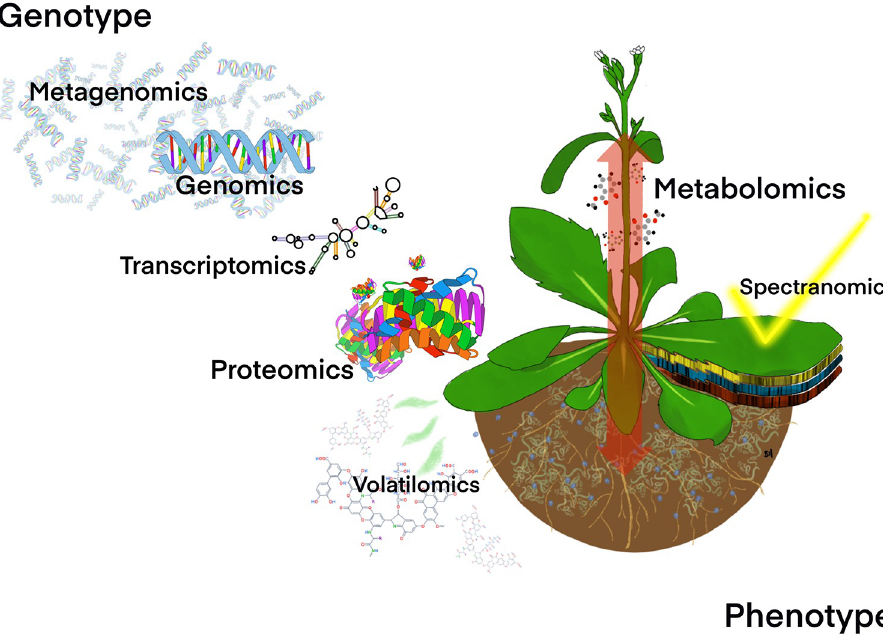
Fig 1. Multi-omics approaches inform the genotype to phenotype cascade. Omics approaches from the genotype (top left) to the phenotype (bottom right) inform plant disease ecology in a holistic manner and can shed light on microbial communities above and belowground. Red arrow on plant symbolizes dynamic intra-plant communication in the metabolome affecting the microbial community through released volatiles. Yellow check is light for spectranomics with multiple bands of sensing (below